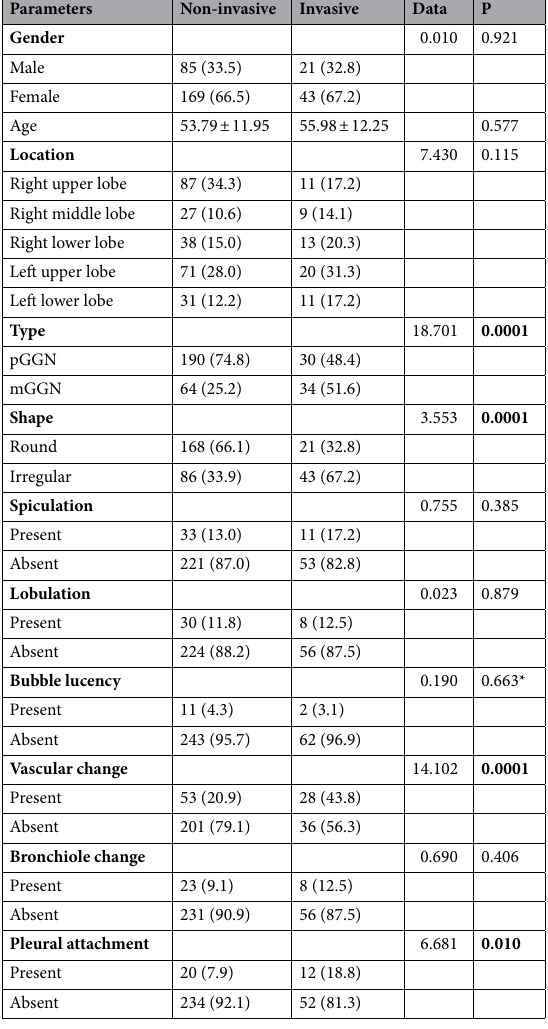
Table 1. Radiographic parameters of all patients in non-invasive and invasive groups. Values are presented as no. (%) or mean ± SD. P value is derived from the univariable association analyses between each of the basal variables and the invasive extent. *Fisher’s exact